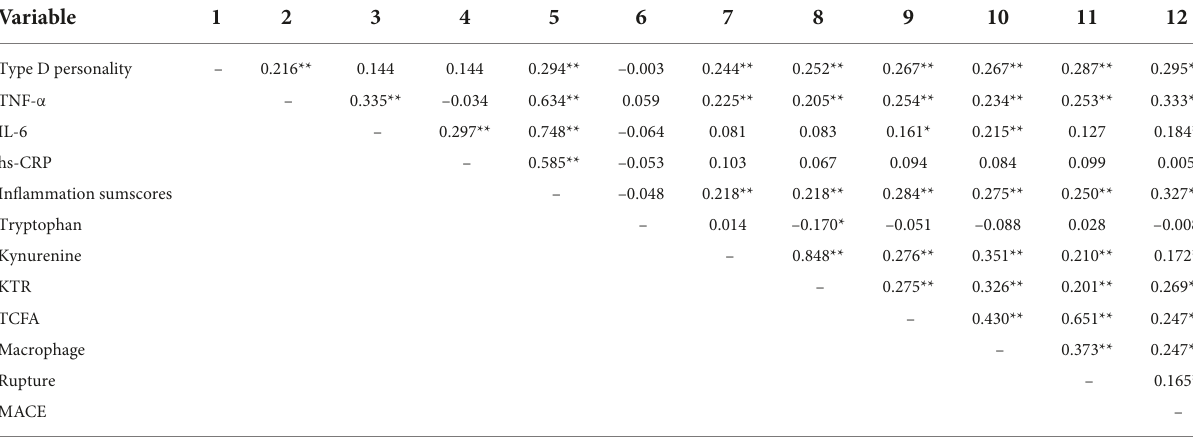
TABLE 4 Correlations between Type D Personality, inflammation sumscores, KTR, and plaque vulnerability. Variable